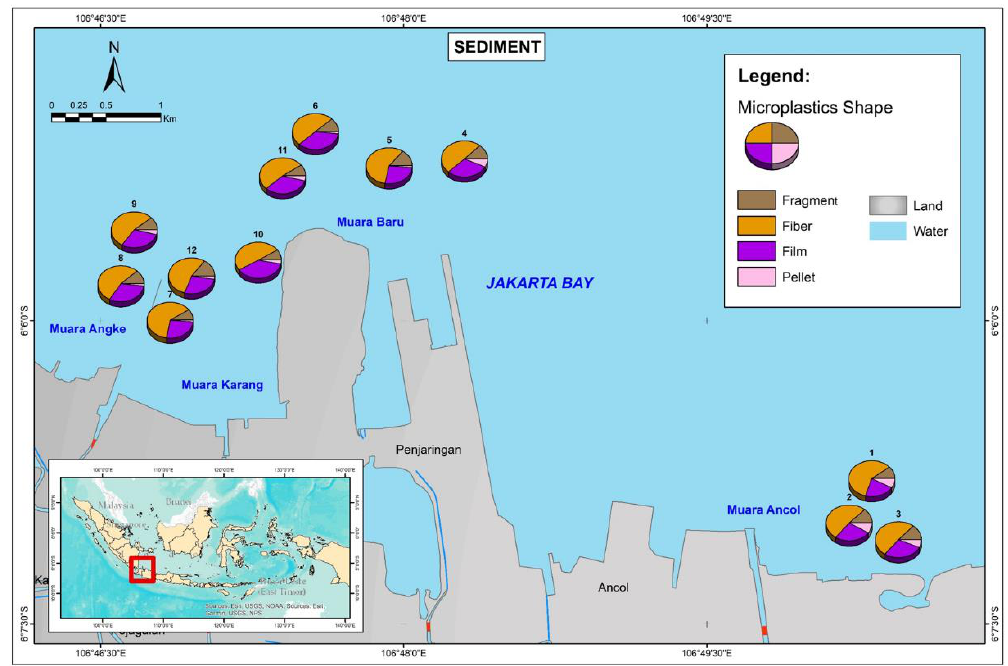
Fig. 5: Distribution and abundance (particles/kg/dry weight) of microplastic in Jakarta Bay sediment